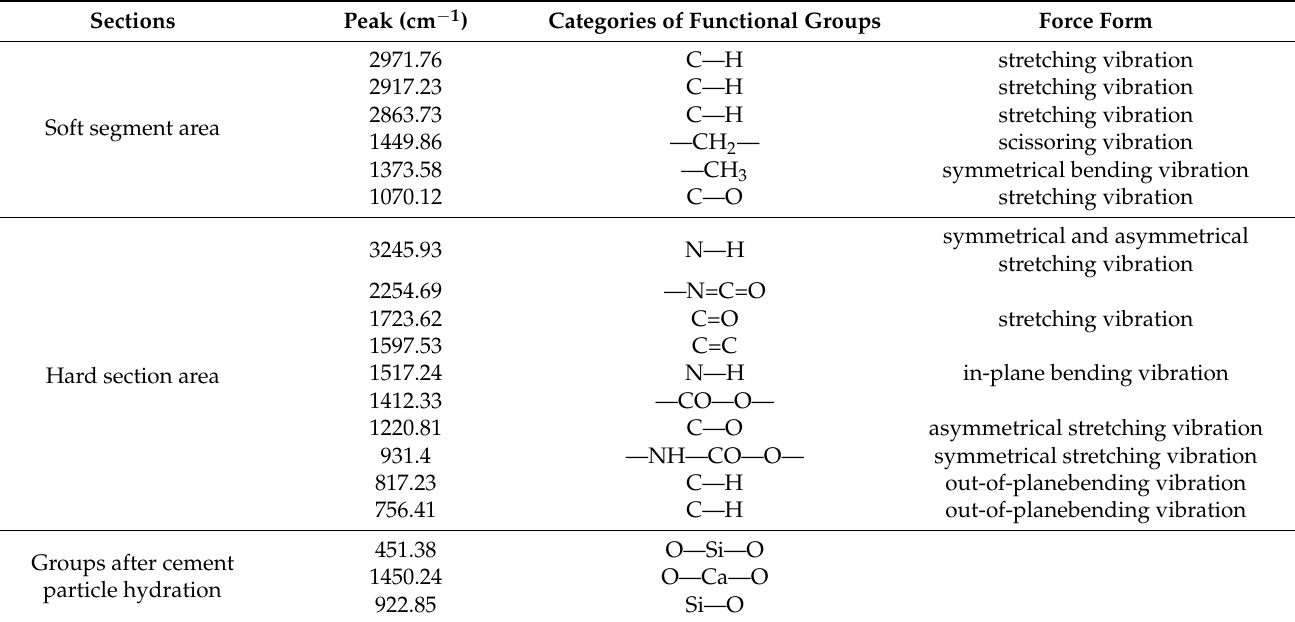
Table 6. Categories of functional groups represented by the peaks in the IR test graph of polyurethane concrete.